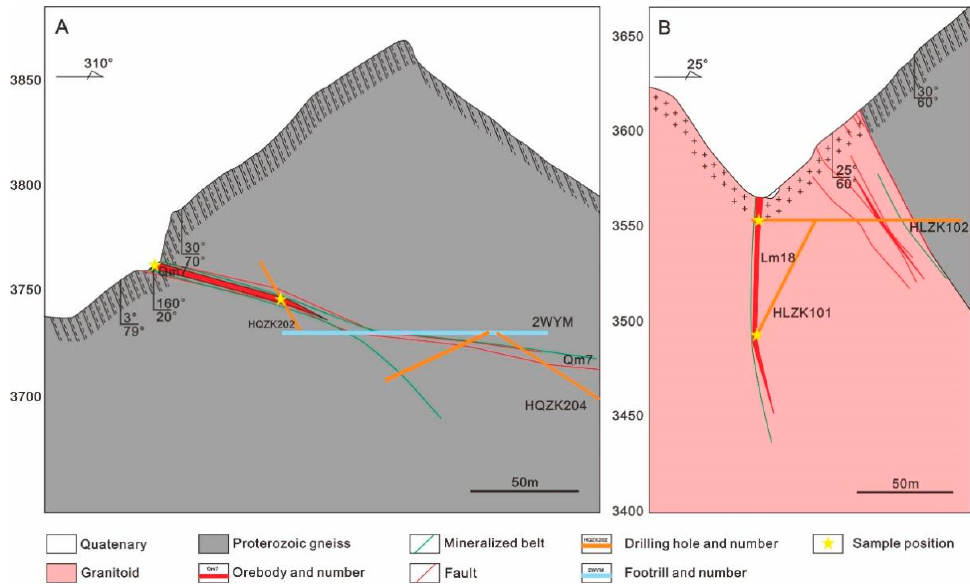
Figure 3. Profiles of the 2nd prospecting line of the Hongqigou deposit ( A ) and the 1st prospecting line of the Huanglonggou deposit ( B ) (modified after the map drawn by Qinghai Geological and Mineral Exploration and Development Bureau, 2015).